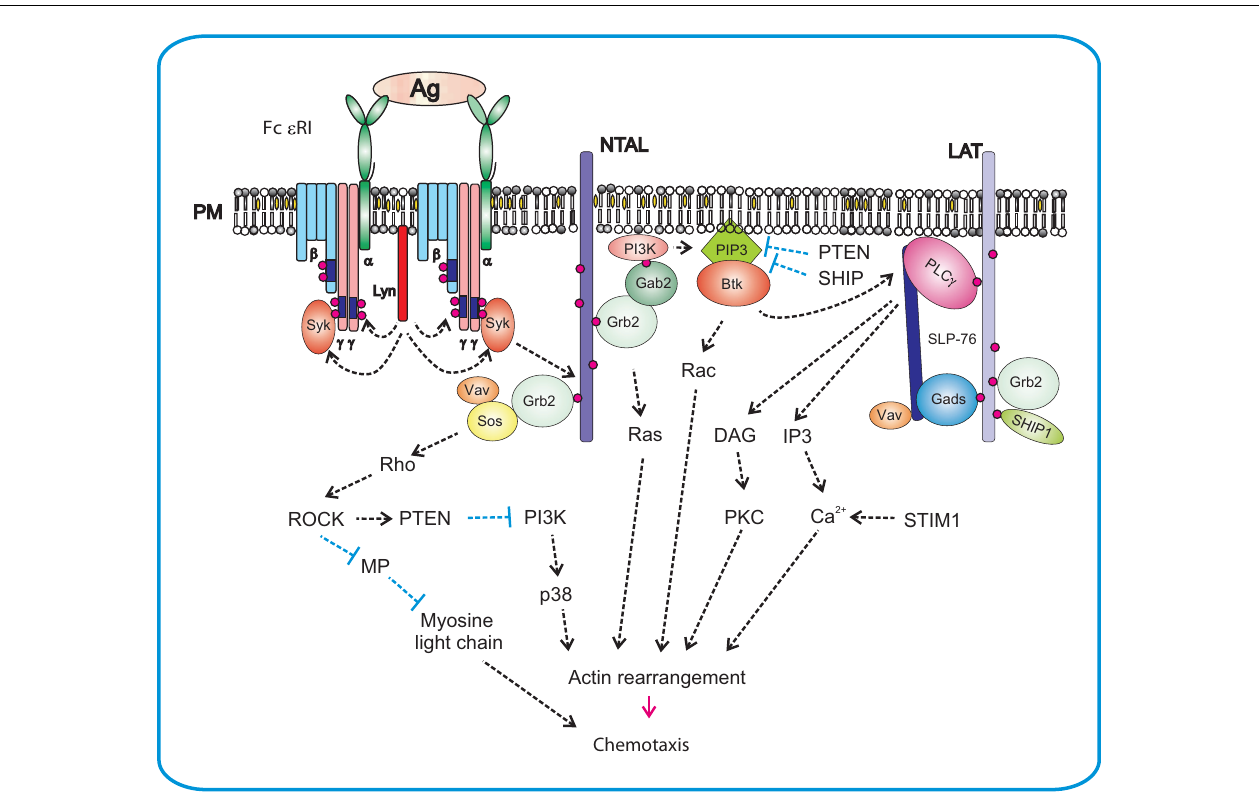
FIGURE 2 |Antigen-mediated chemotaxis. Aggregation of the Fc ε RI by multivalent antigen leads to rapid Lyn kinase-mediated phosphorylation of tyrosine residues in ITAM motifs of Fc ε RI β and γ subunits.This is followed by anchoring of Syk to Fc ε RI γ through interaction of Syk SH2 domains with phosphorylated ITAMs. Syk then phosphorylates transmembrane adaptor proteins NTAL and LAT and creates binding sites for various SH2-containing proteins like Grb2. In this way it brings PI3K and Gab2 to the plasma membrane. Activated PI3K generates PIP3, a binding site for PH-domain containing protein Btk.This leads to further propagation of the signal through activation of PLC γ , resulting in Ca 2 + release and actin